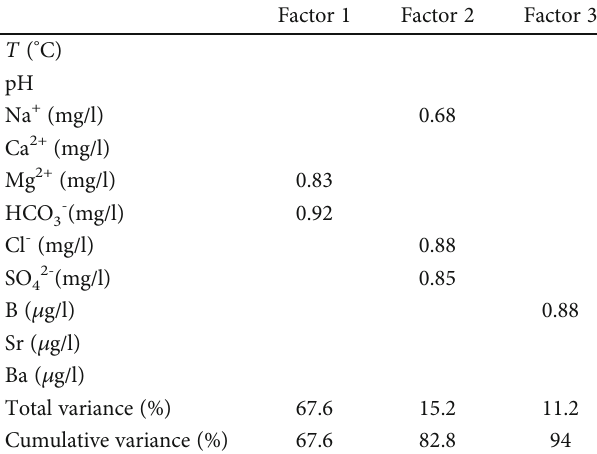
Figure 7: Binary plot of Ca 2+ + Mg 2+ vs. HCO The symbols are as Figure 5.